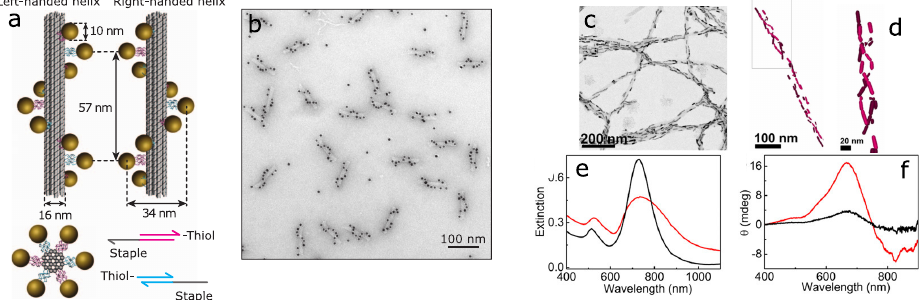
Figure 3. Biomolecule-assisted chiral assemblies: ( a , b ) gold nanoparticles assembled by DNA origami in left- and right-handed nanohelices. ( a ) Schematics, ( b ) TEM image. Reproduced with permission from Kuzyk et al. [53] Copyright 2012 Springer Nature. ( c – f ) Detection of Amyloid Fibrils using gold nanorods. ( c ) TEM image and ( d ) cryo-TEM tomography reconstruction of a composite α -synuclein fiber showing the 3D chiral arrangement of Au nanorods; ( e ) extinction and ( f ) CD spectra of Au nanorods monitored 30 min after the addition of 30 µ L of purified brain homogenates from healthy (black) and Parkinson-disease-affected (red) patients Adapted with permission from Kumar et al. [60] Copyright 2018 National Academy of